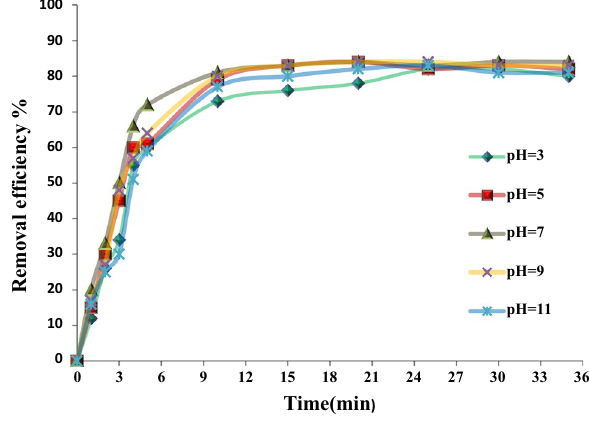
Fig. 5 Change of pH with time of OTC (OTC conc. = 50 mg/l, ozone generation rate = 1.38 mg/s, at room